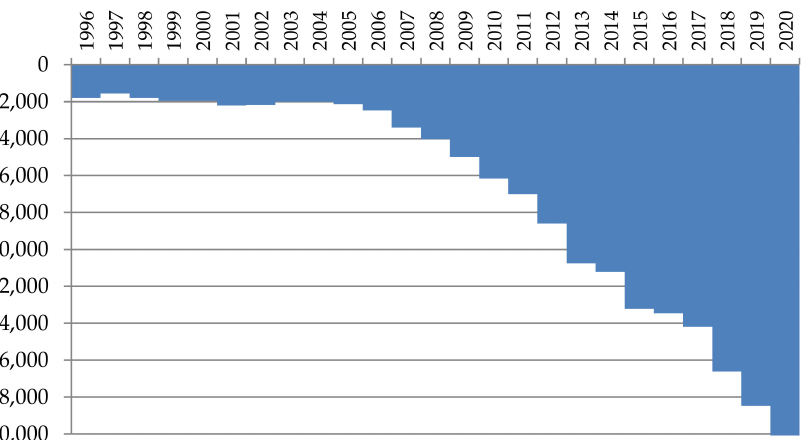
Figure 9. Evolution of the length of front pages of Spanish online media (in pixels). Compiled by the